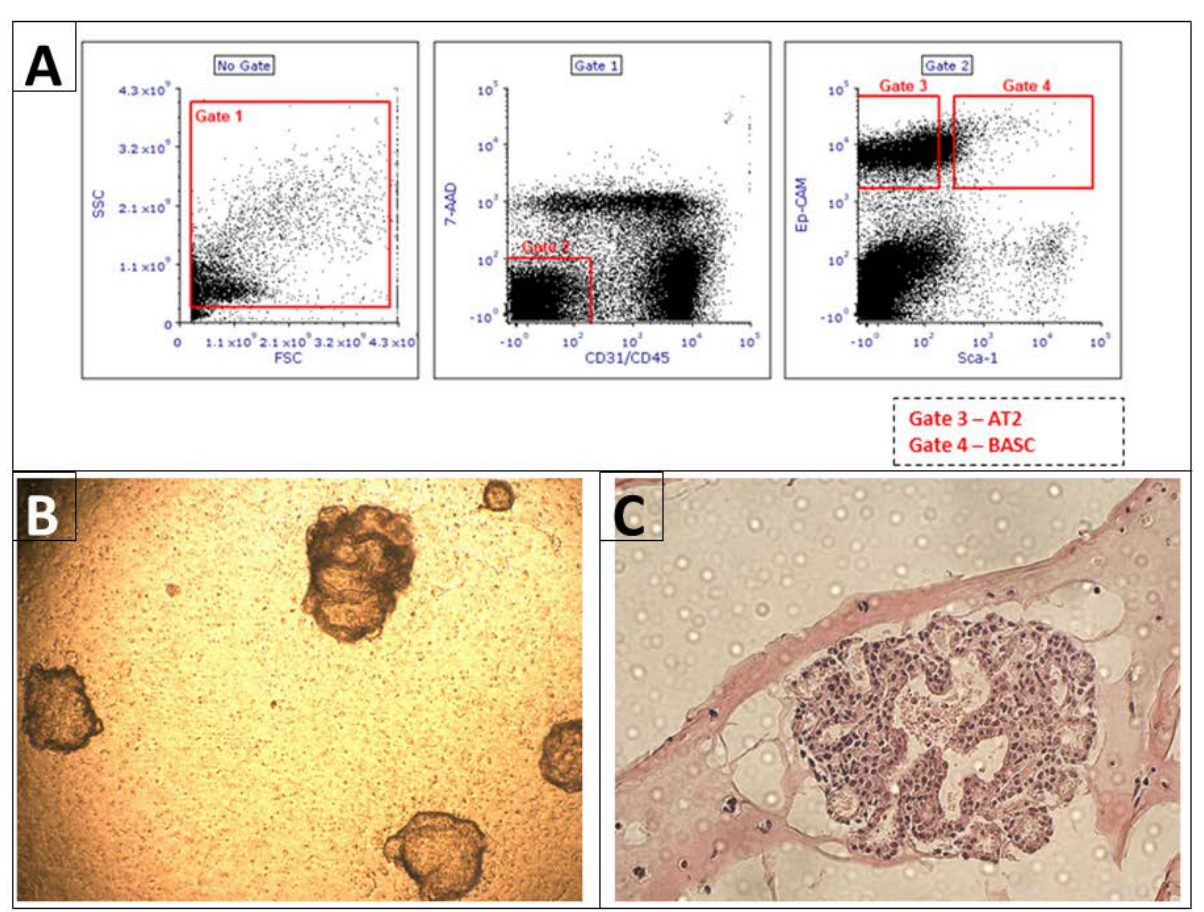
Figure 1. Isolation of alveolar type II cells and bronchioalveolar stem cells by FACS and 3D organoid culture started with FACS isolated cells carried out in a Matrigel. Panel ( A ): A representative plot showing the gating strategies used to isolate AT2 and BASC cells from mouse lungs. The gates were set to isolate in gate 3 AT2 (CD31 negative, CD45 negative, Ep-CAM positive, Sca-1 negative) and in gate 4 BASCs (CD31 negative, CD45 negative, Ep-CAM positive, Sca-1 positive). Panel ( B ): shows whole three-dimensional structure of organoid. These cultures are run for 21 days in the presence of pulmonary fibroblasts. Photograph of unstained organoid grown in insert was taken in brightfield with the use of light microscope at a 10 × magnification. Panel ( C ): Organoid sections isolated at 21st day of culturing, paraffin embedded, 3 µ m thick and H&E stained. Photograph was taken in brightfield at a 20 ×